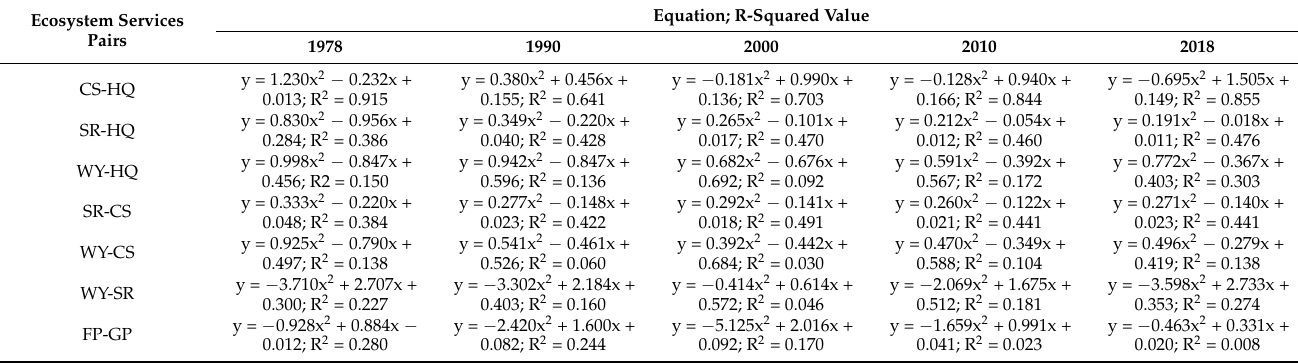
Table A2. Equations of fitted curves for ecosystem services pairs with